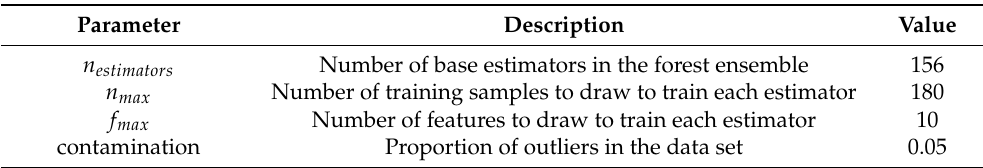
Table 4. Model hyperparameters for IF. Parameter Description Value n estimators Number of base estimators in the forest ensemble 156 n max Number of training samples to draw to train each estimator 180 f max Number of features to draw to train each estimator 10 contamination Proportion of outliers in the data set